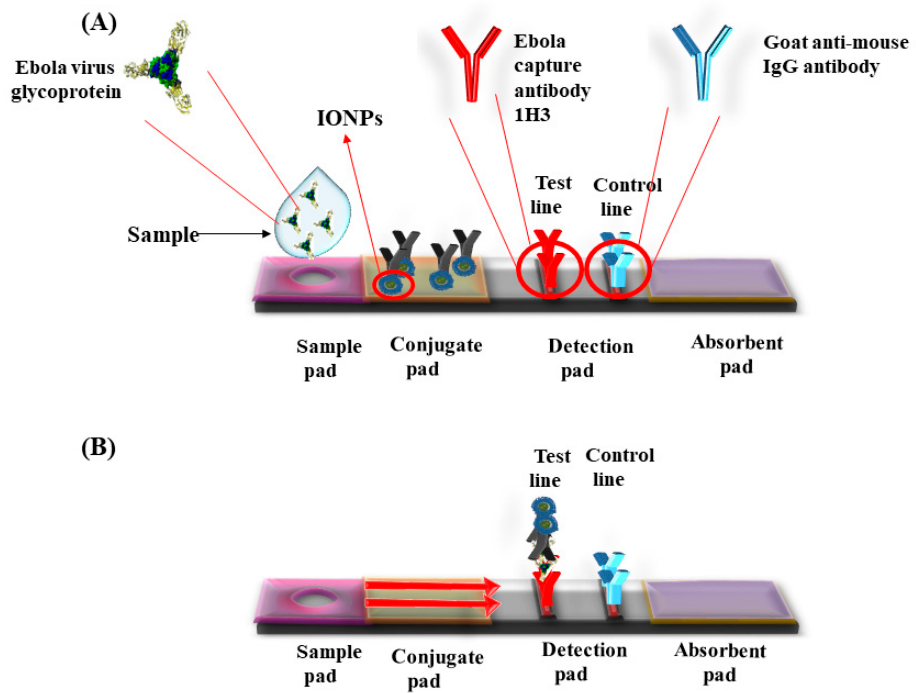
Figure 2. Lateral flow dipstick device for the detection of Ebola virus using Iron oxide nanoparticles (IONPs). ( A ) Ebola capture antibody 1H3 coated on test line and control line coated with goat anti-mouse IgG antibody. Sample was applied in the sample well. ( B ) The sample runs via capillary action on the membrane. Presence of specific antigen for Ebola developed color in the detection pad. Table 2. Chemically synthesized and modified IONPs nanozymes and its application for the detection of various biological compounds. Serial No.